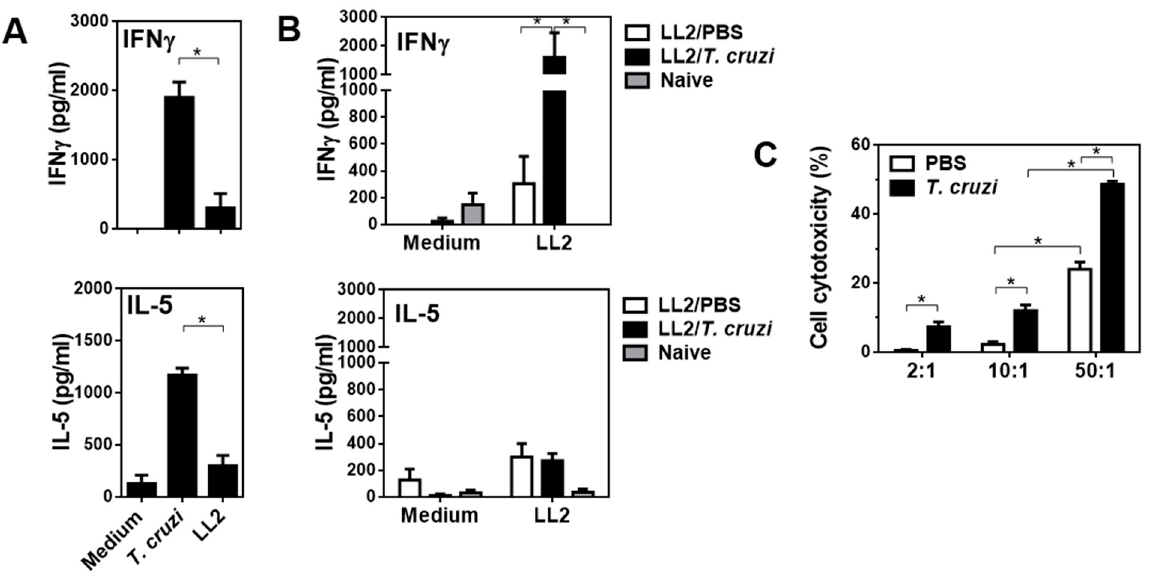
Figure 3. T. cruzi -treatment induces high production of IFN- γ by specific splenocytes with higher cytotoxic capacity: ( A ) Splenocytes (0.5–1 × 10 6 /well) from non-LL/2-tumour bearing mice immu- nised at days 4, 7 and 11 with T. cruzi and restimulated either with T. cruzi or LL/2 lysate (20 µ g/mL). Spleens were collected on day 19 from sacrificed mice. ( B ) Alternatively, mice were challenged with LL/2 cells (100,000 cells/mouse) on day 0 and treated with T. cruzi lysate or PBS in alum on days 4, 7, and 11. Splenocytes from LL/2 tumour-bearing mice or naive mice were cultured in the presence or absence of an LL/2 lysate (20 µg/mL). Cultures were maintained at 37 °C for three days. Cytokine levels were measured in culture media by specific sandwich ELISA. ( C ) Splenocytes (effector cells, E) from tumour-bearing mice with or without T. cruzi treatment were cultured in presence of LL/2 cells (target cells, T). After overnight incubation at 37 °C, cells were stained with WST-8. Representative results from two independent experiments are shown (±SEM, indicated by error bars). Asterisks indicate statistically significant differences (* p < 0.05) by student t -test.